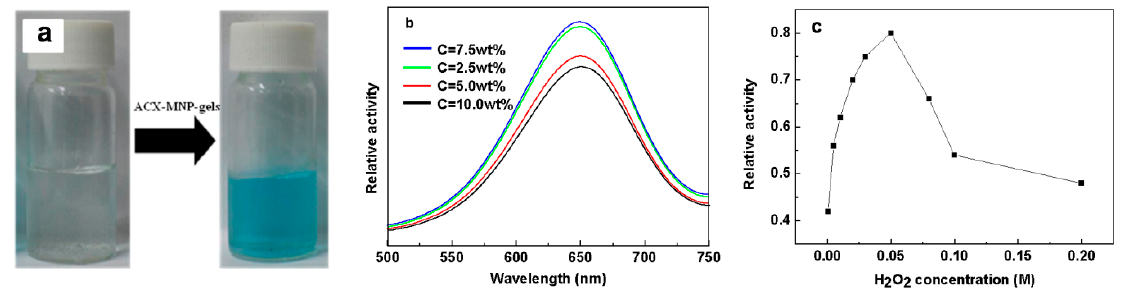
Figure 9. ( a ) Color variations in the catalytic experiment; ( b ) Relative activity of the ACX-MNP-gels with different C; ( c ) H 2 O 2 concentration-response curve using the ACX-MNP-gels (C = 7.5 wt %) as a catalyst under the same reaction conditions and with a H 2 O 2 concentration range of 5 uM to 200 mM.